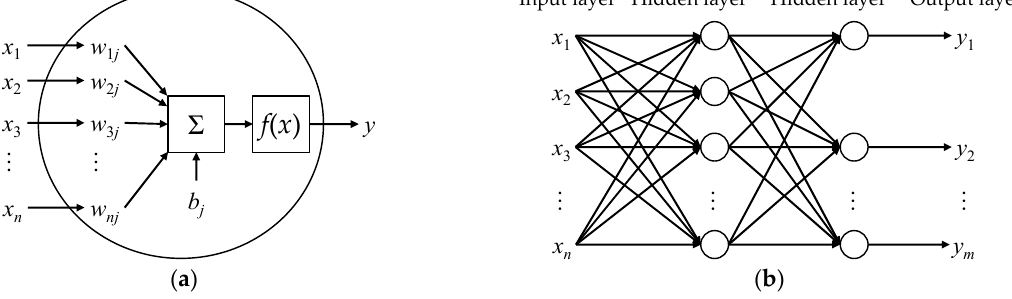
Figure 11. The schematic diagram of Artificial Neural Network: ( a ) a neuron; and ( b ) the artificial neural network.